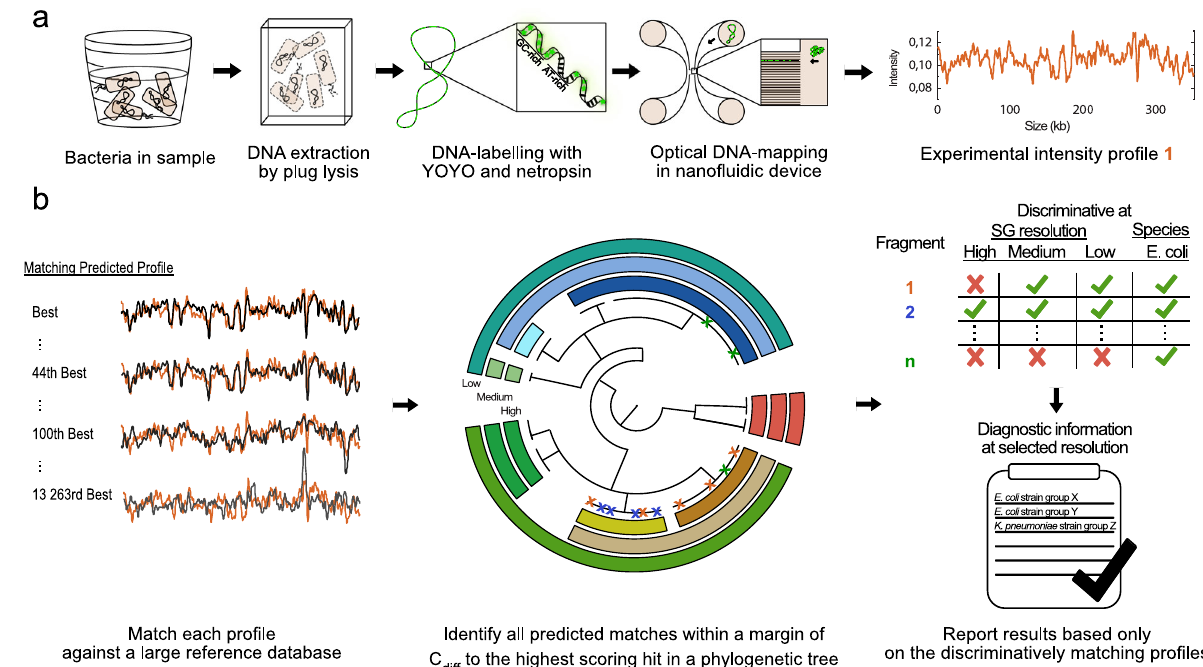
Fig. 1 Schematic overview of high-resolution optical DNA mapping-based bacterial typing. a Experimental pipeline. The DNA, extracted via plug-lysis, is labelled with YOYO-1 and netropsin in a single step. The DNA is con fi ned to nano fl uidic channels and imaged using a fl uorescence microscope, resulting in one experimental intensity pro fi le per analysed DNA fragment. b Data analysis pipeline. Each experimental intensity pro fi le is matched to the reference database of predicted intensity pro fi les. Next, the database matches are fi ltered for each experimental pro fi le so that only high-scoring matches remain. Pro fi les are deemed to match discriminatively if all remaining matches are against a single strain group (SG) at the investigated resolution. Only the results of the discriminative pro fi les are reported back to the user. The result for the sample is shown as the number of discriminative fragments matching each detected SG and the proportions of all discriminative pro fi les matching each detected